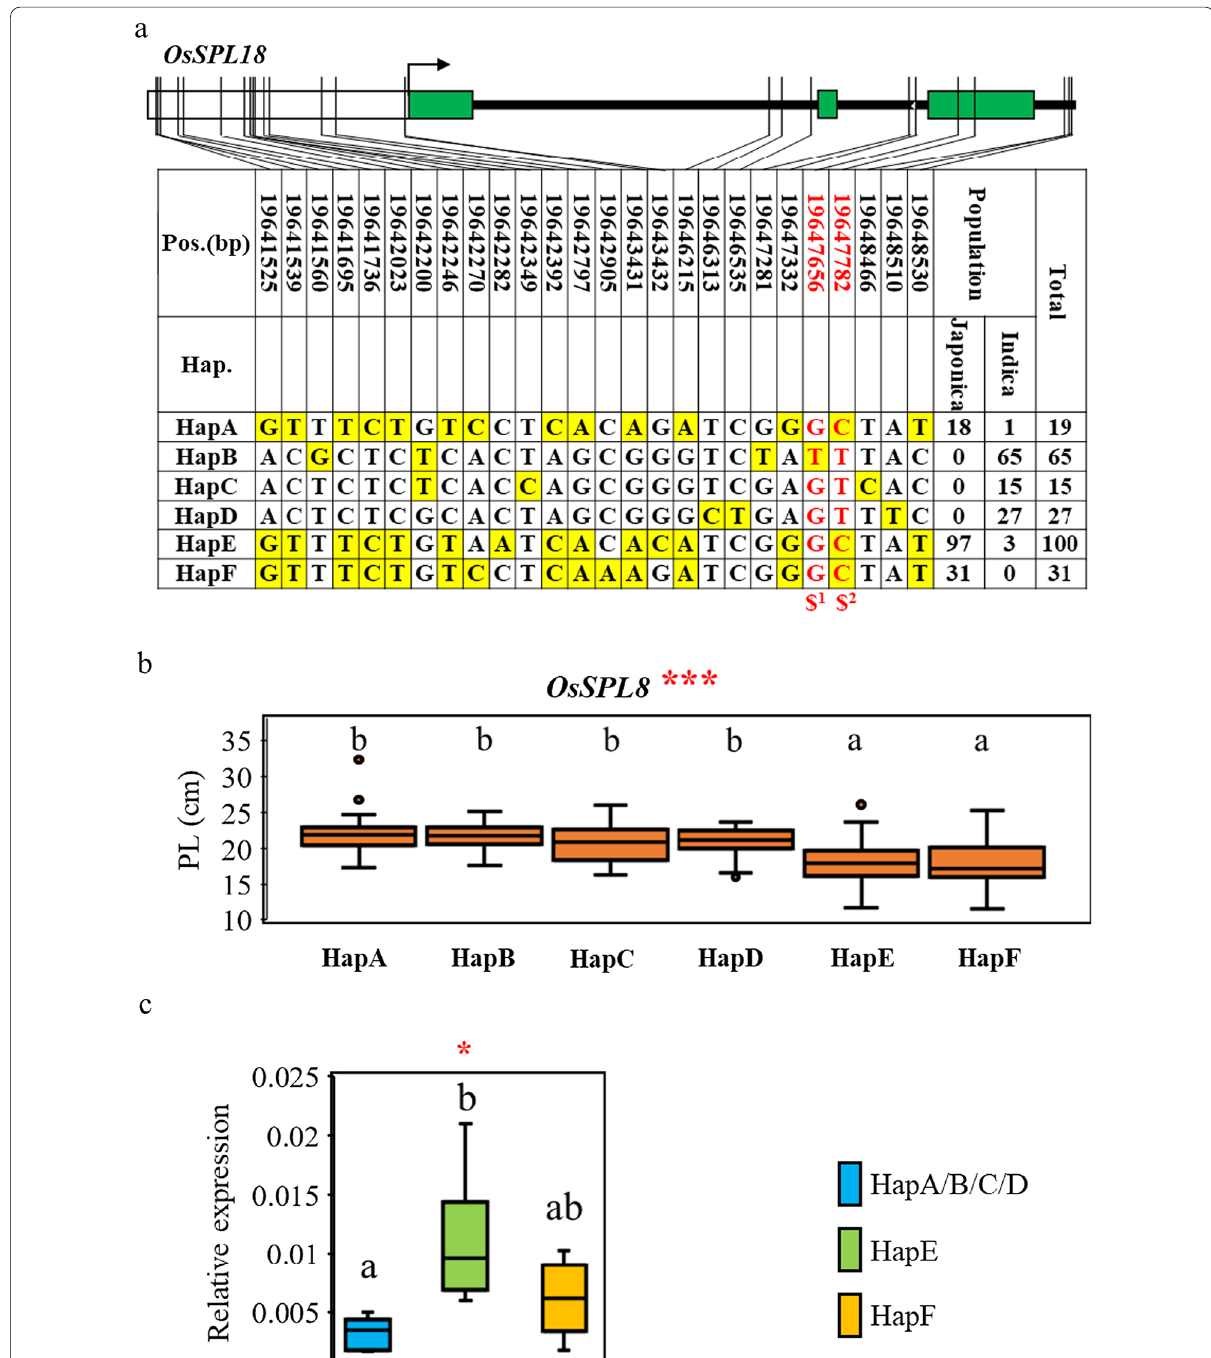
Fig. 3 Haplotype analysis of OsSPL18 . a Six haplotypes of SPL18 based on 26 SNPs observed in all assessed rice accessions. The schematic representation of SPL18 gene structure (upper) shows the promoter as a white box, exons as green boxes, and introns and intergenic regions as black lines. Thin black lines indicate the genomic position of each SNP. Haplotypes with fewer than 10 accessions are not shown. Yellow highlight indicates SNP alternatives. The SNP in red and bold is a non- synonymous SNP. ‘$ 1 ’ indicates a missense mutation from Gly to Val. ‘$ 2 ’ indicates a missense mutation from Thr to Met b–c Box plots for b panicle length based on the six haplotypes for SPL18 in 2017 and c OsSPL18 expression levels in different haplotypes relative to OsActin1 . Boxes show median, and upper and lower quartiles. Whiskers extend to 1.5 range, with any remaining points indicated with dots. * P < 0.05, *** P < 0.001 (ANOVA). Letters indicate significant differences, P < 0.05 (Duncan’s multiple comparison